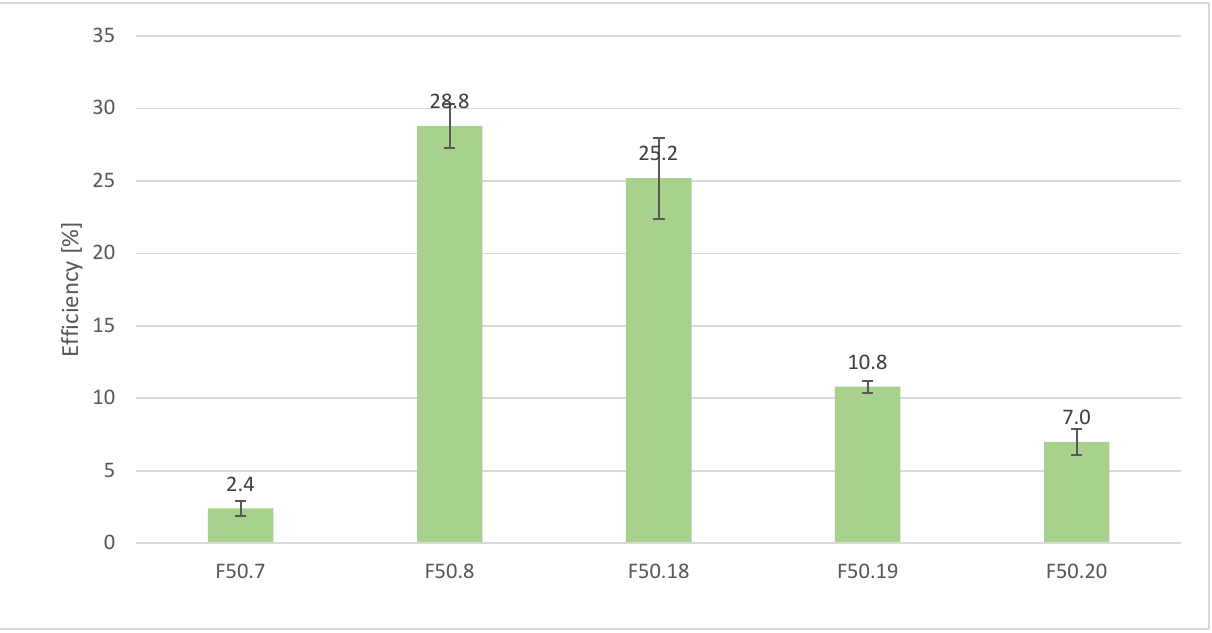
Figure 6. The efficiency of the formulations F50.7 (Mg(OH) 2 = 130; PCC = 0), F50.8 (Mg(OH) 2 = 40; PCC = 90), F50.18 (Mg(OH) 2 = 30; PCC = 100), F50.19 (Mg(OH) 2 = 90; PCC = 40), F50.20 (Mg(OH) 2 =100; PCC = 30) . Standard deviation ranges are